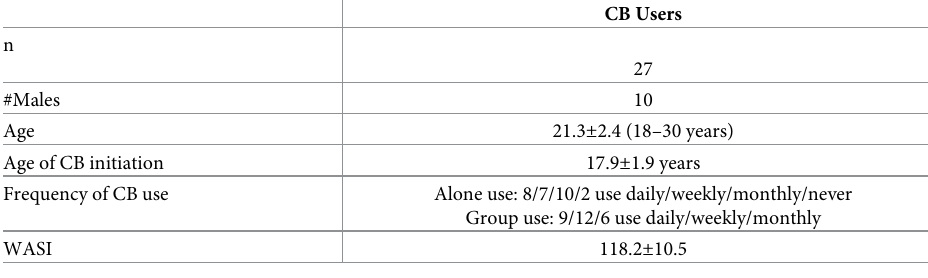
Table 1. Experiment 2